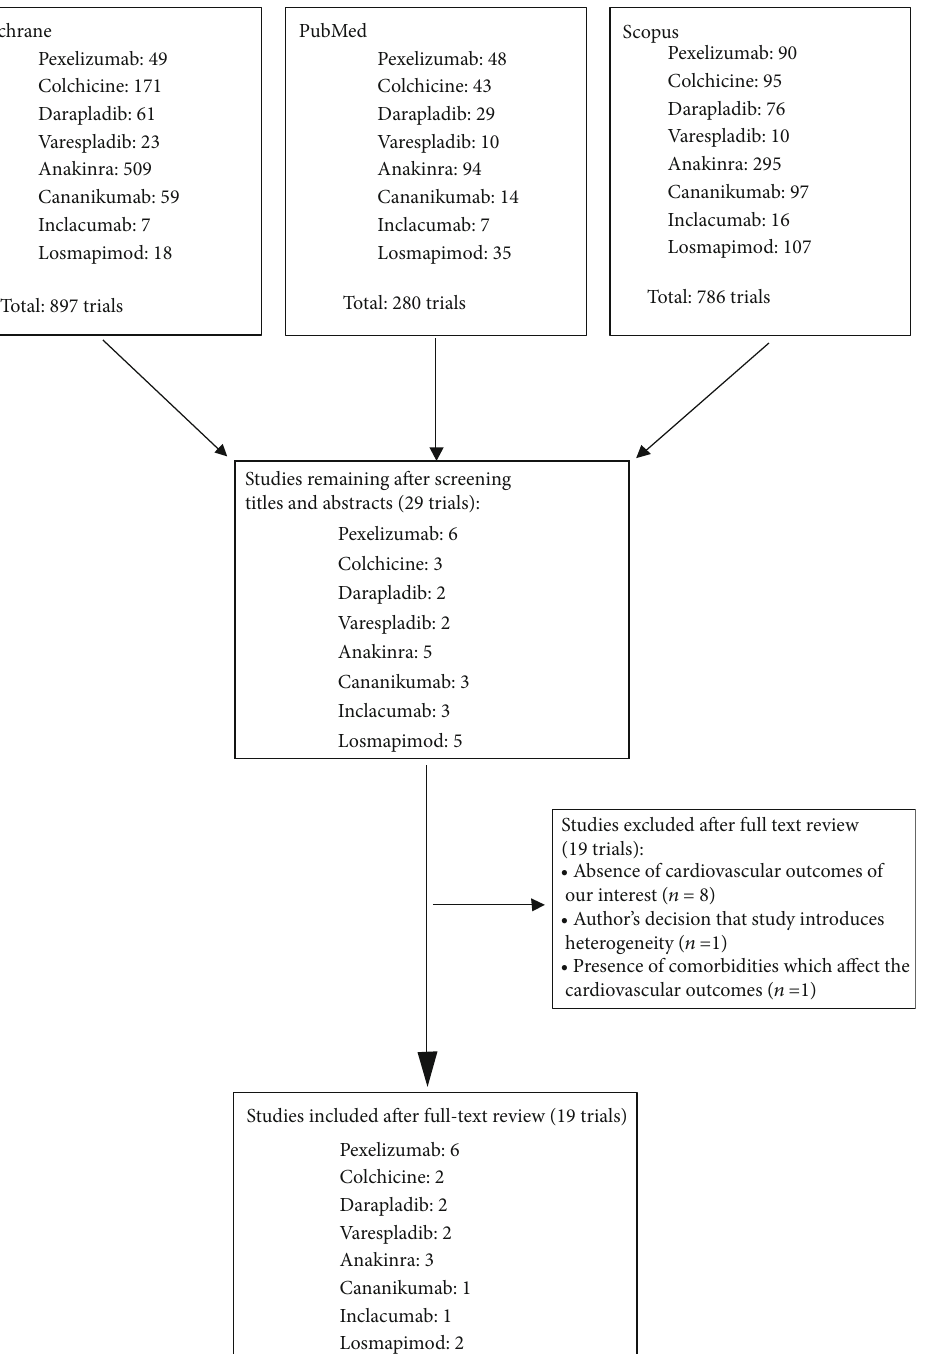
Figure 1: Flow chart showing the search algorithm and fi nal study selection in the